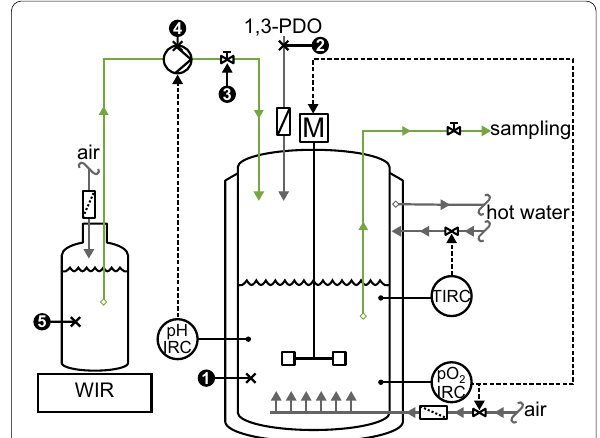
Fig. 2 Schematic representation of the process. 1. Bioconversion medium. 2. Addition of filter‑sterilized 1,3‑PDO. 3. Manual valve opened when bioconversion starts. 4. Feed pump, activated depending on pH measurements. 5. Alkali and substrate mix. Solid arrows indicate fluid streams while dotted lines indicate electronic signals. M. Stirring motor. IRC. Indicator, recorder and controller of the concerned parameter [pH, pO 2 , temperature (T)]. WIR. Weight indicator and